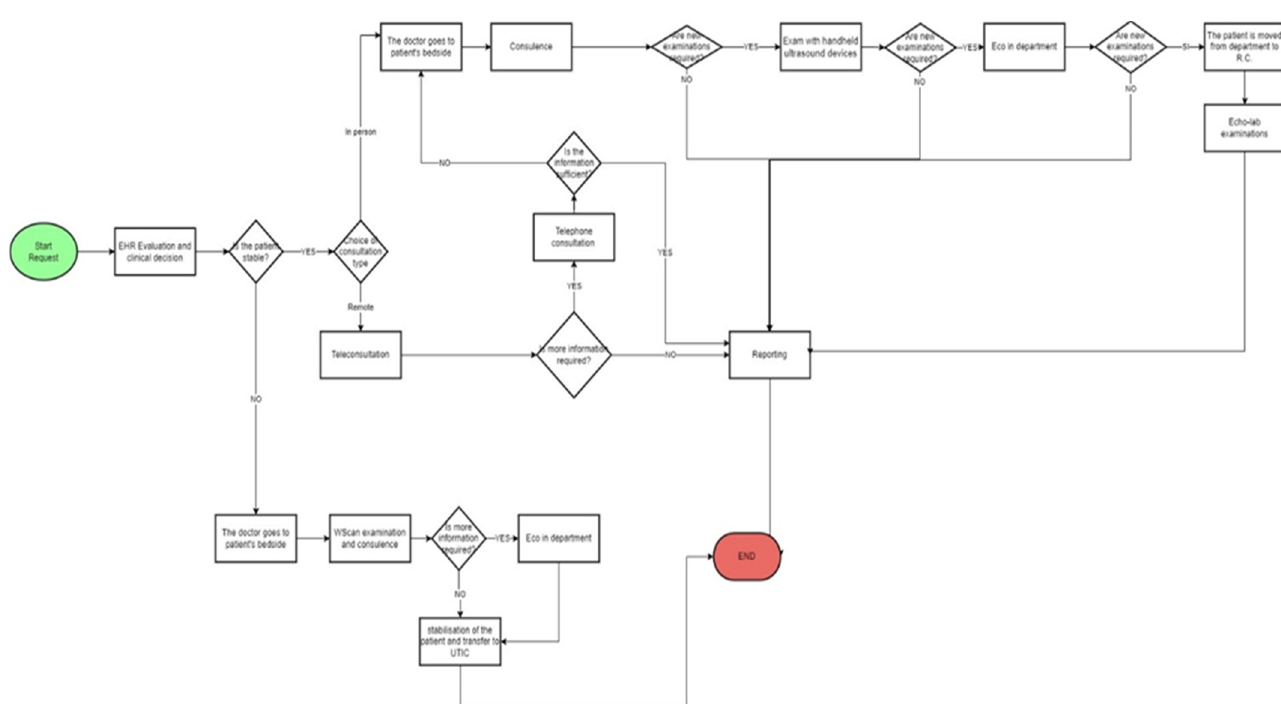
Figure 3. Flow chart of the consultation process after the Lean management intervention.